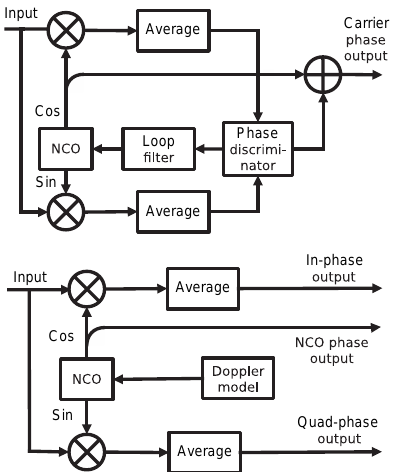
Figure 1. Schematic representation of closed-loop (top panel) and open-loop (bottom) carrier signal tracking. In closed-loop mode the input signal is correlated with two replica signals, sin and cos, and the latter is phase-shifted by 90 ◦ with respect to the former. The cor- relation sums are low-pass filtered and the output is examined for phase deviations between input and replica signal. The discrimina- tor adjustments close the feedback loop. Open-loop tracking (bot- tom panel) dispenses with the phase discriminator and the numeri- cally controlled oscillator (NCO) is solely steered from model val- ues (Doppler model). The observed carrier phase finally is assem- bled from the NCO phases and the in-phase and quad-phase corre- lation